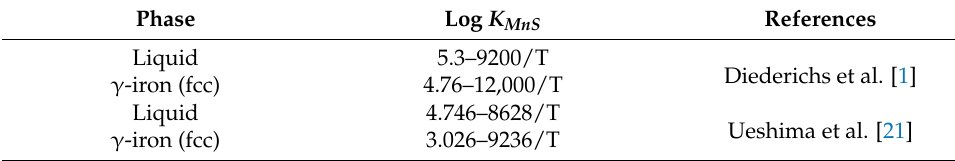
Table 4. Solubility products for MnS in different phases.